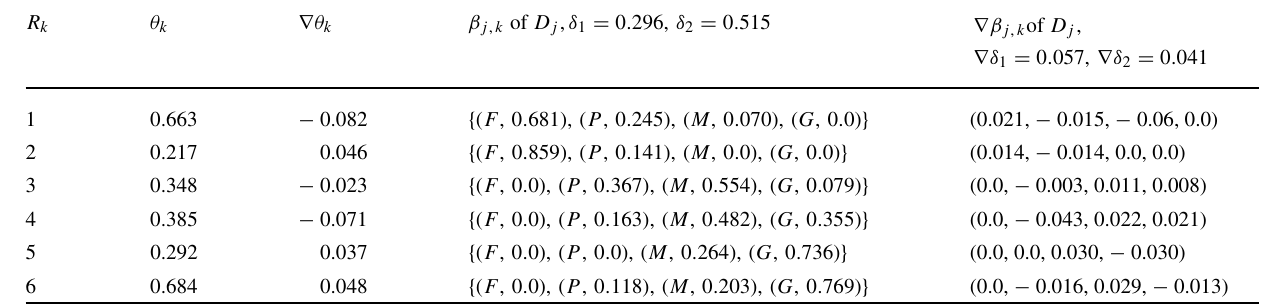
Table 3 Parameters of the generalized BRB model and changes in the dedicated BRB model